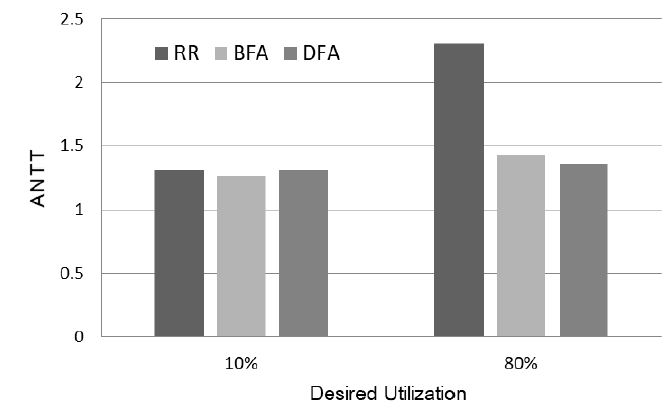
Figure 6. Performance comparison of the scheduling policies as the desired utilization is varied.